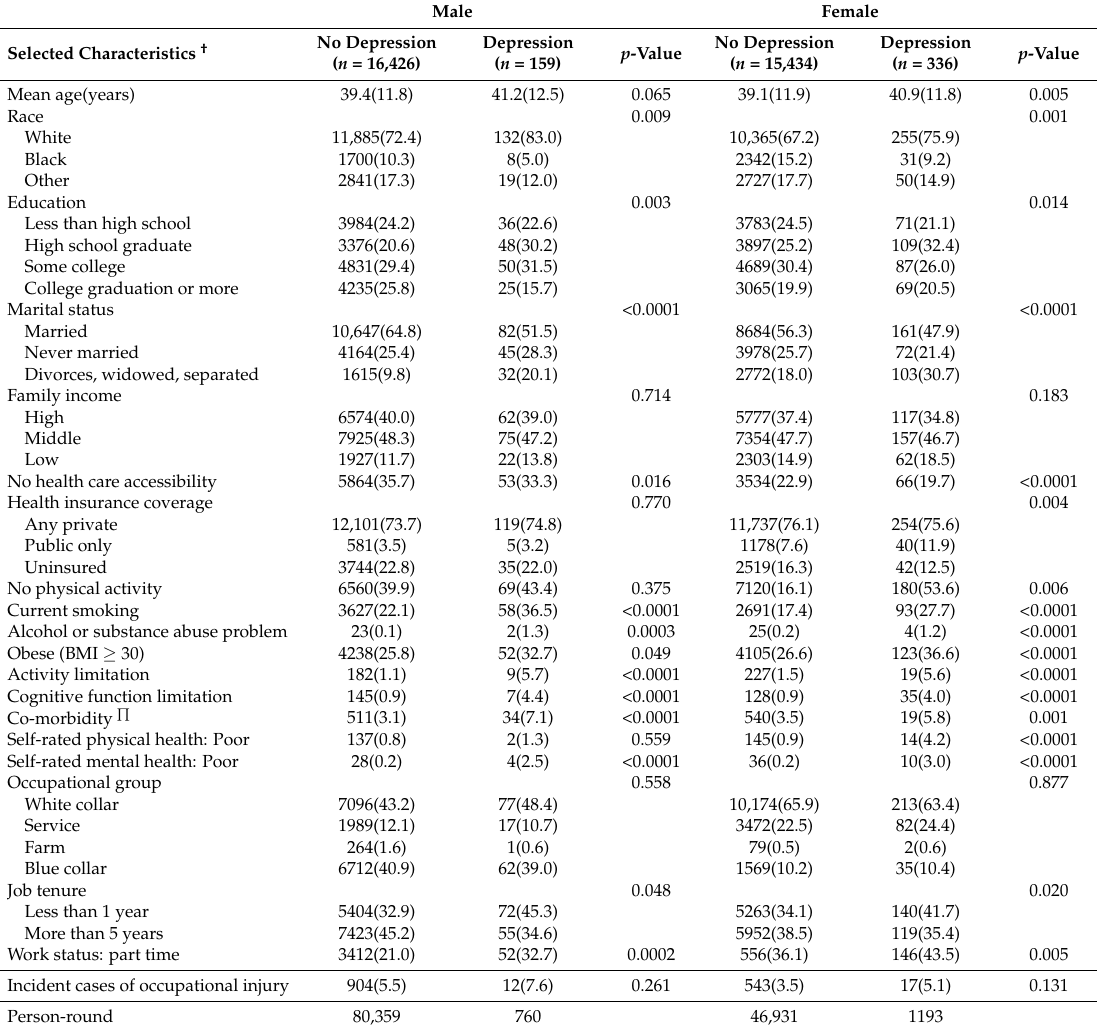
Table 4. Characteristics of men and women without prevalent injury by depression status in the MEPS, 2000–2006.